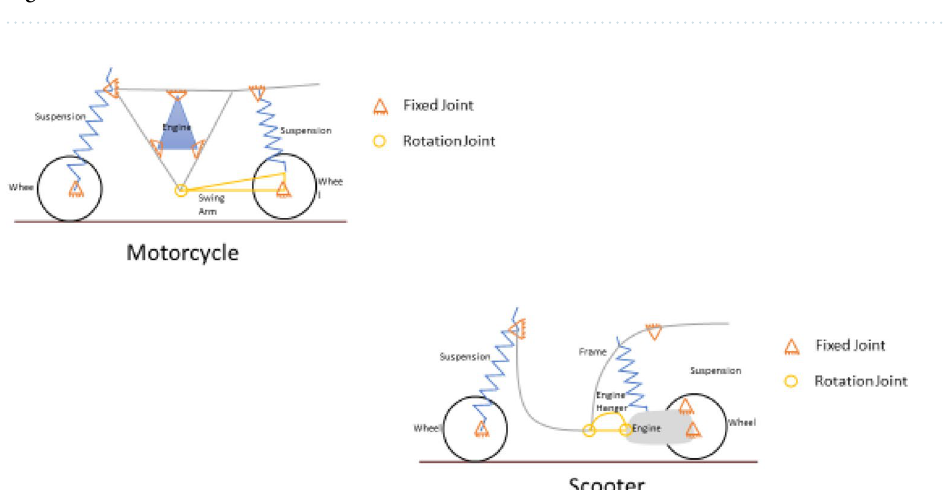
Figure 5. The difference between a motorcycle and a scooter: a schematic